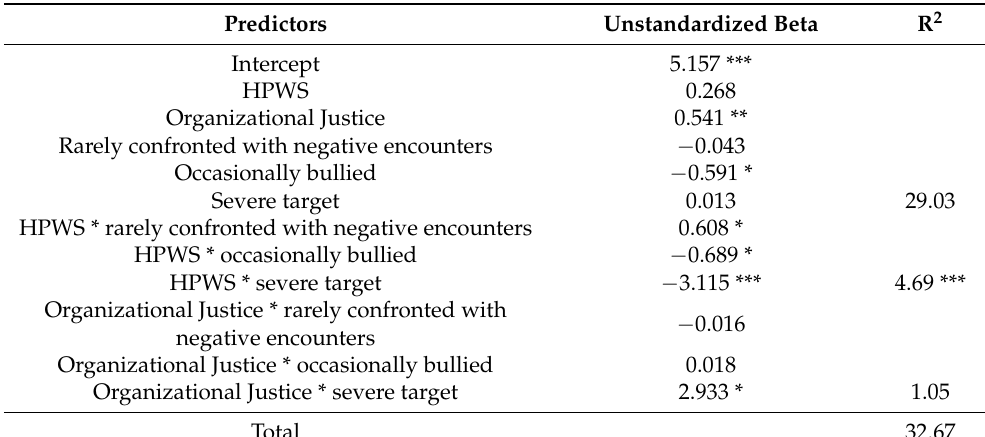
Table 3. Results of the Moderation Mediation Analyses for engagement, including workplace bullying as a categorical variable (based on LCCA). Predictors Unstandardized Beta R 2 Intercept 5.157 *** HPWS 0.268 Organizational Justice 0.541 ** Rarely confronted with negative encounters − 0.043 − 0.591 *